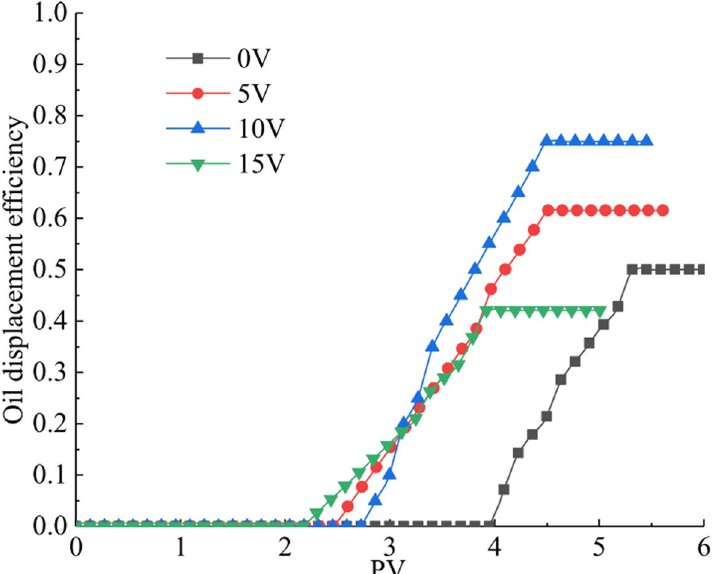
Fig. 9 Results obtained by Zhang et al. [65] showing the relationship between oil displacement and PV under the influence of direct